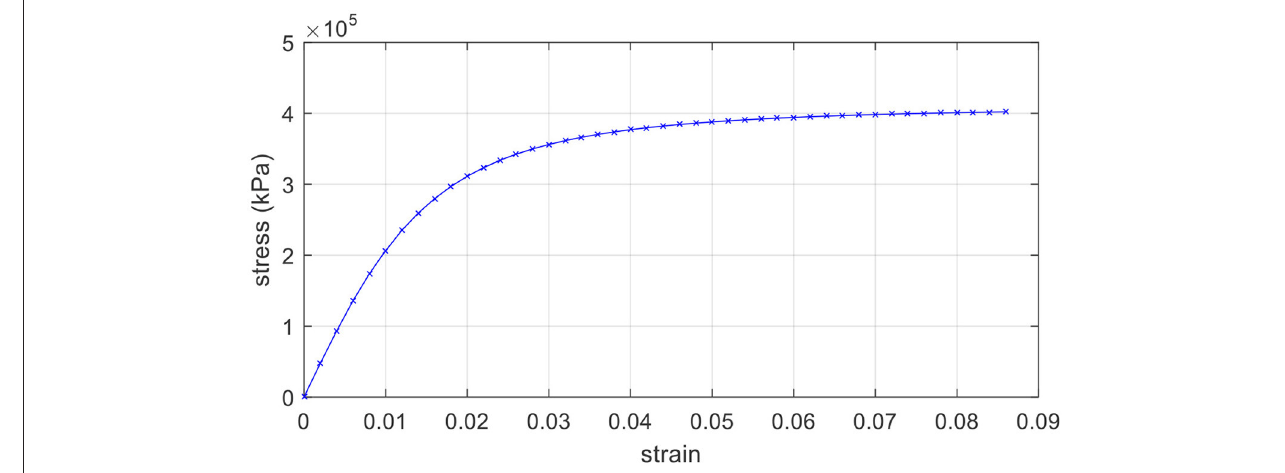
FIGURE 8 | Stress-strain curve for the nonlinear material in Example 2.